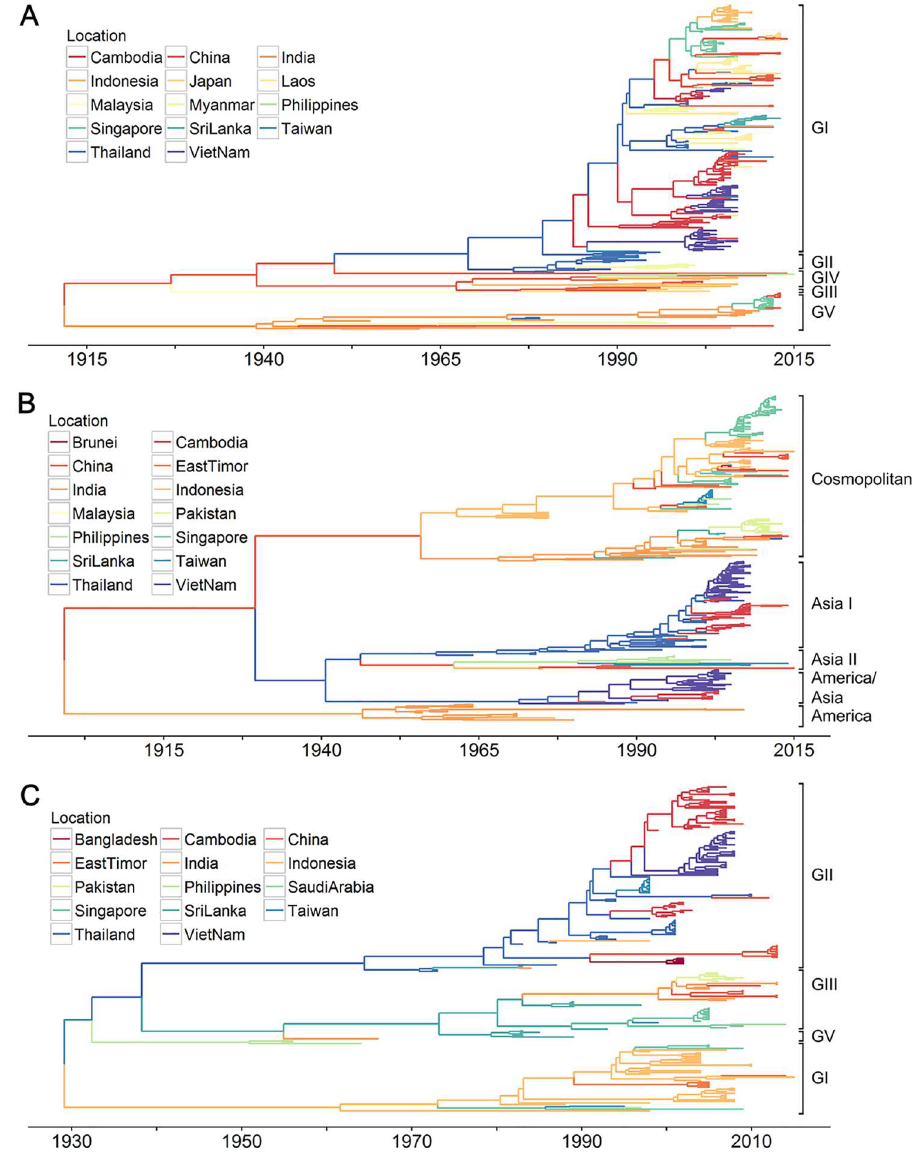
Fig 4. Maximum clade credibility trees of E gene of dengue virus serotypesin Asia. (A) Phylogeographicmolecularclock phylogenyof DENV-1 (n = 327), (B) DENV-2 (n = 357), (C) DENV-3 (n = 202, after removalof sylvatic lineages). Branches are coloredaccordingto most probablegeographic location,as inferred using a Bayesian discrete non-reversible phylogeographicapproach.